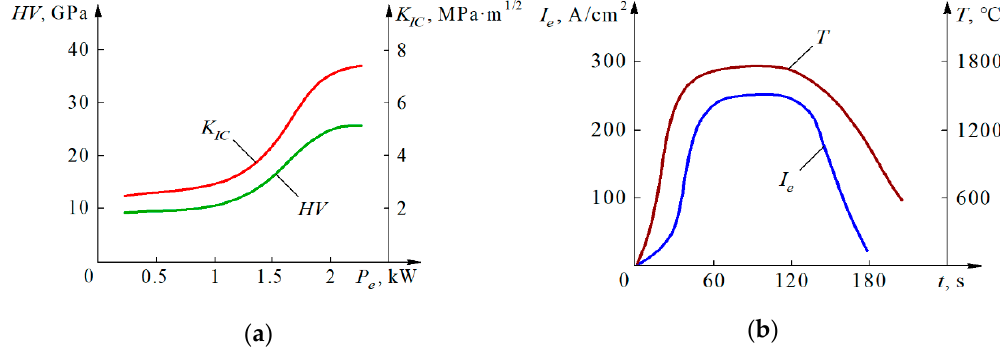
Figure 8. Effect of the process parameters on the characteristics of sintered WC: ( a ) Impact of the electric power P e on hardness HV and fracture toughness K IC ; ( b ) Changes of the current density I e and temperature T during the process.